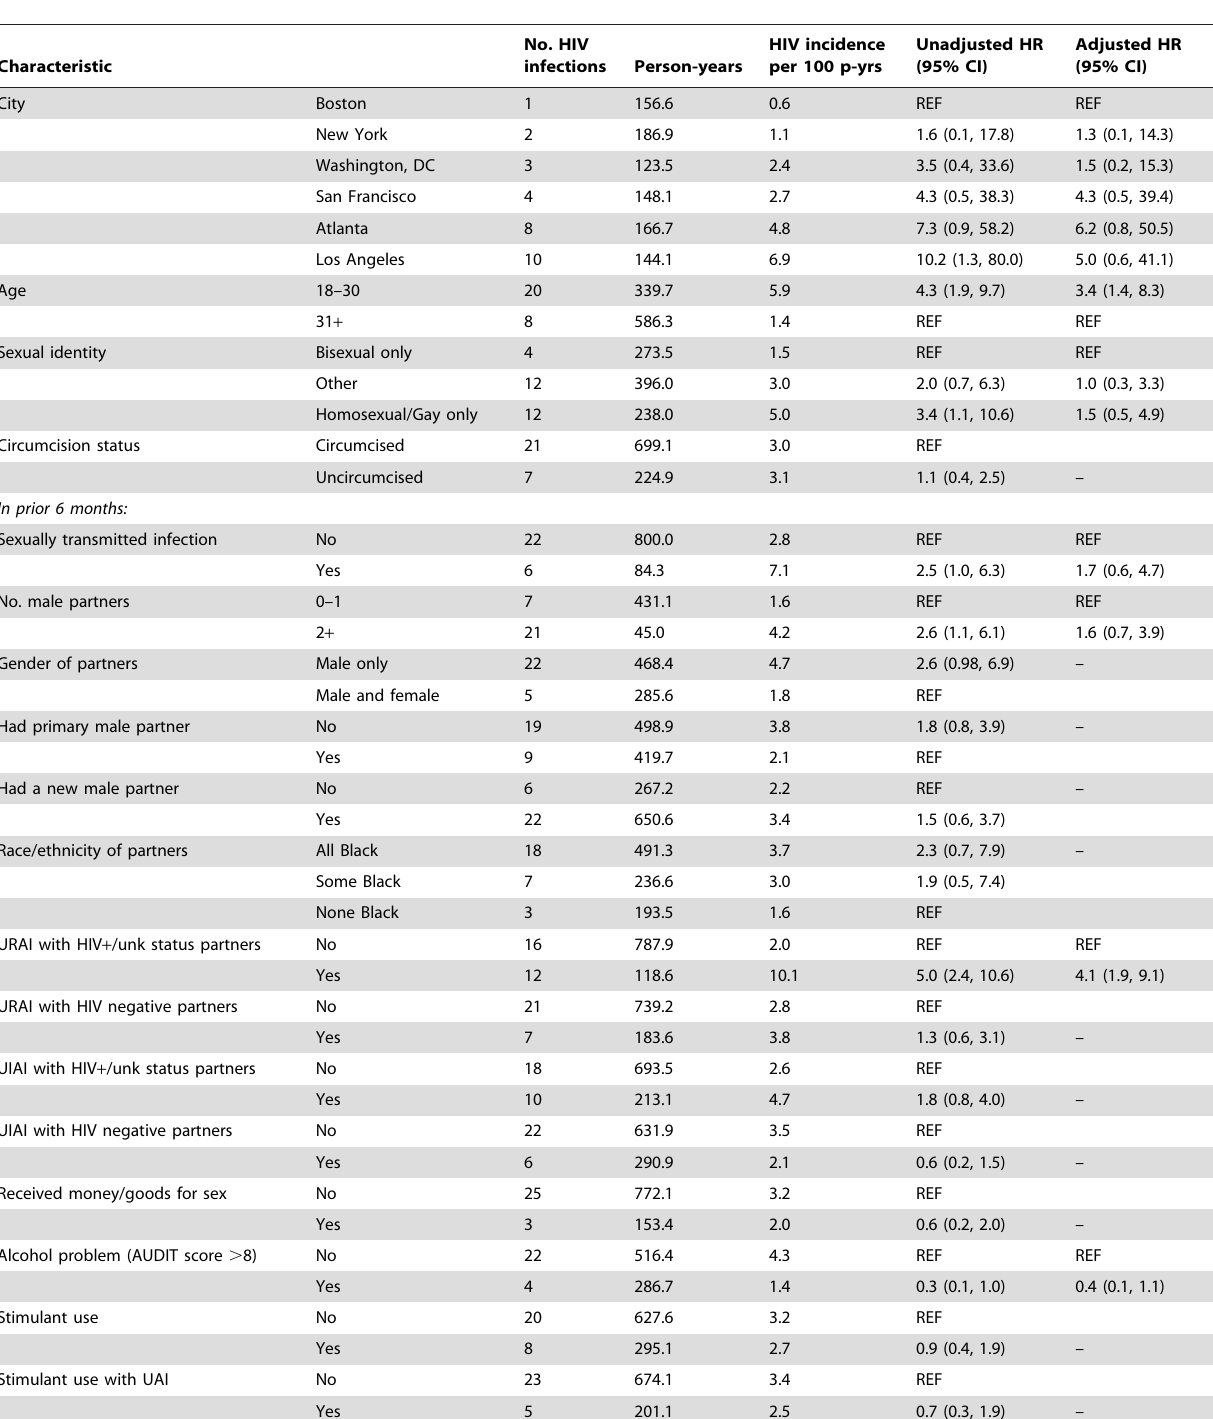
Table 2. HIV incidence rates with time-dependent Cox proportional hazard models among Black MSM, HPTN 061.